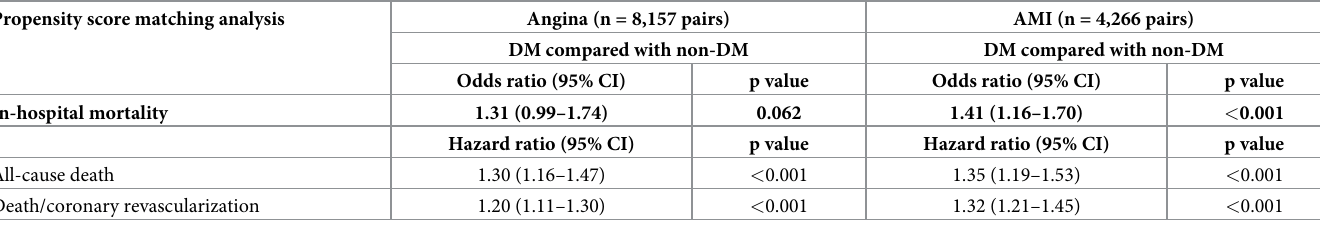
Table 3. Clinical outcomes in patients who underwent percutaneous coronary intervention according to the presence of diabetes mellitus. Propensity score matching